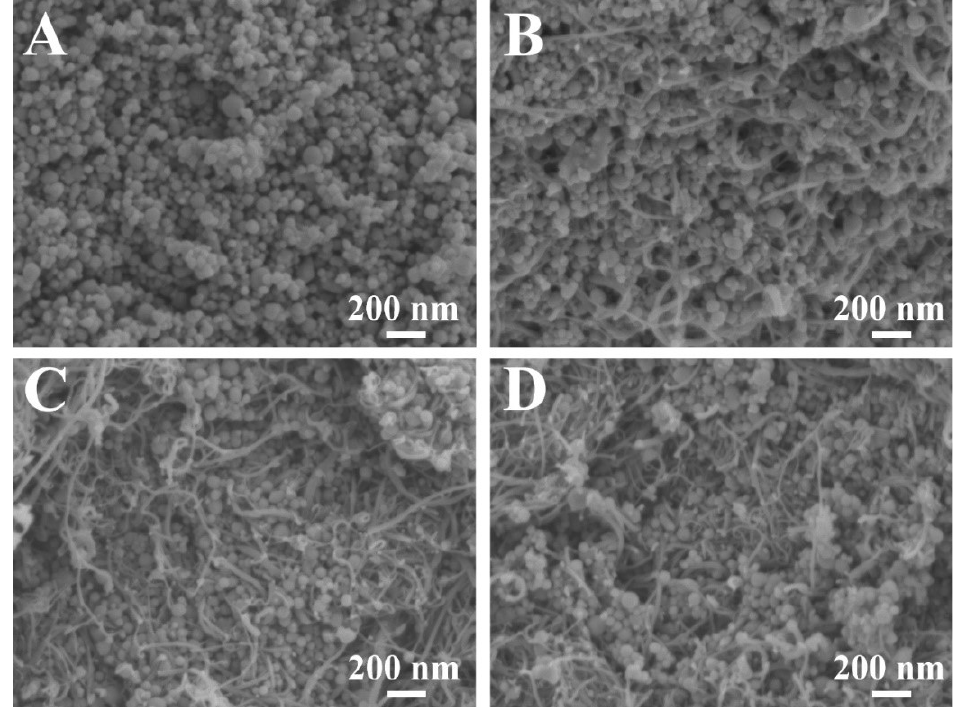
Figure 4. SEM images of ( A ) CFO-0, ( B ) CFO-10, ( C ) CFO-20 and ( D ) CFO-30 electrodes.